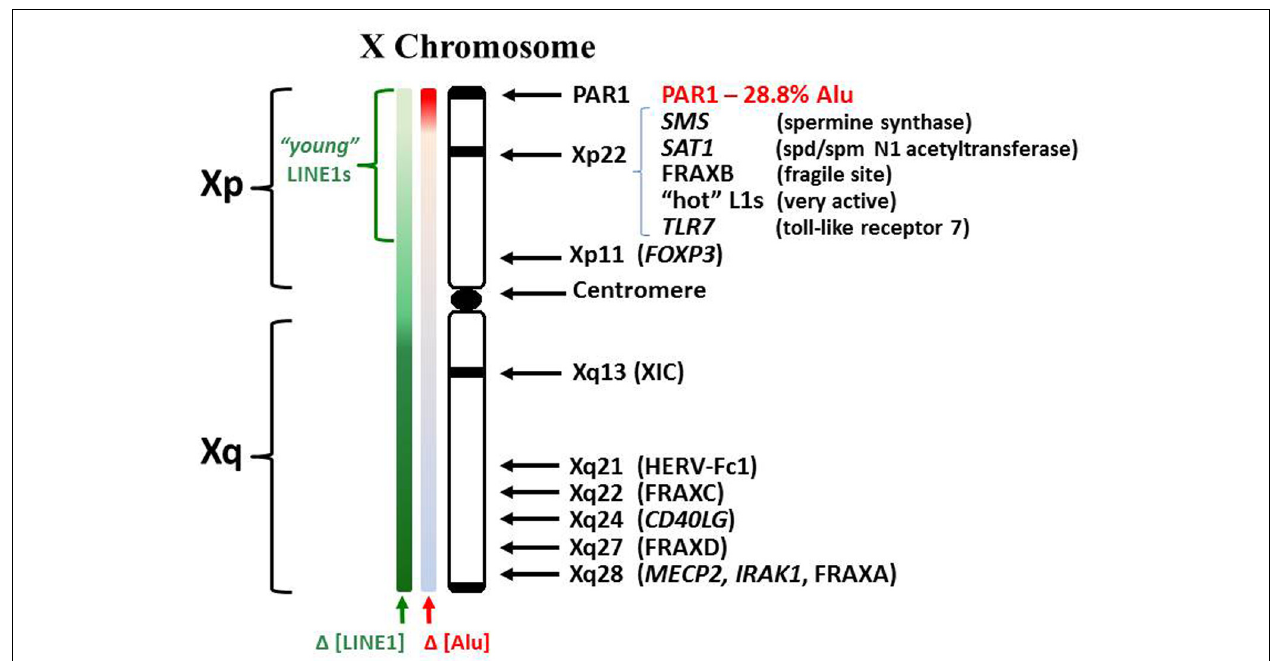
chromosome (Ross etal., 2005). L1 content drops in Xp but consists of more recently incorporated L1s, some still capable of reverse transcription. Lower L1 content in Xp suggests potential difficulties in maintaining Xp inactivation. Alu elements comprise ∼ 10.8% of the human genome but only 8% of the X. However, the PAR1 region is 28.8% Alu. Alus contain an internal RNA pol III transcription site but are usually suppressed by a positioned